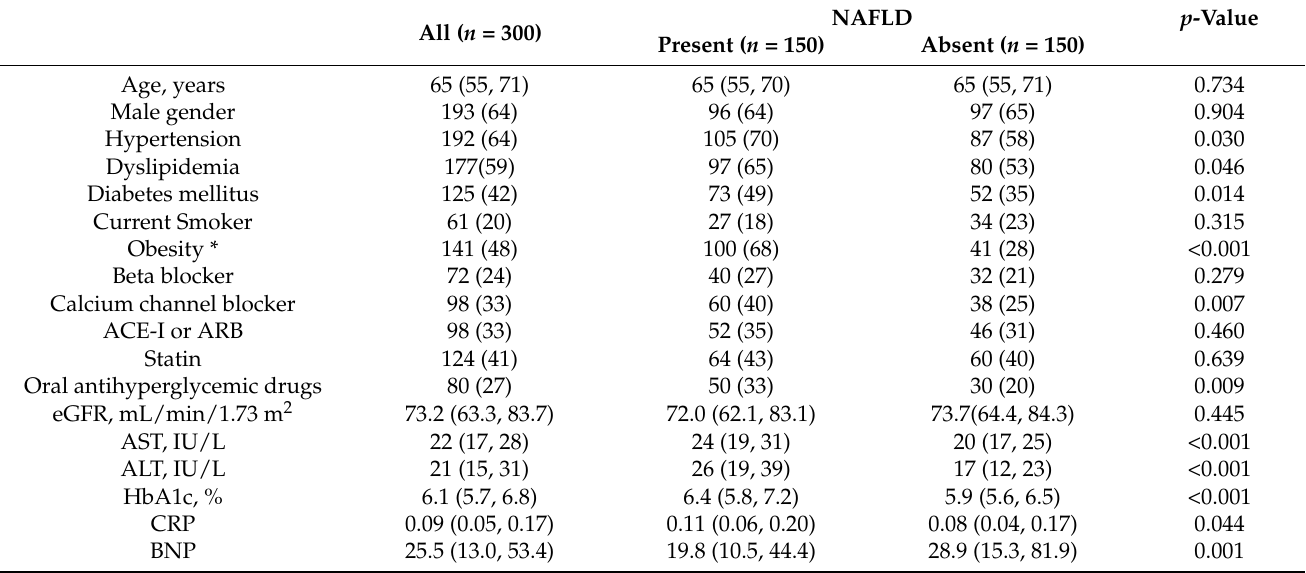
Table 1. Patients’